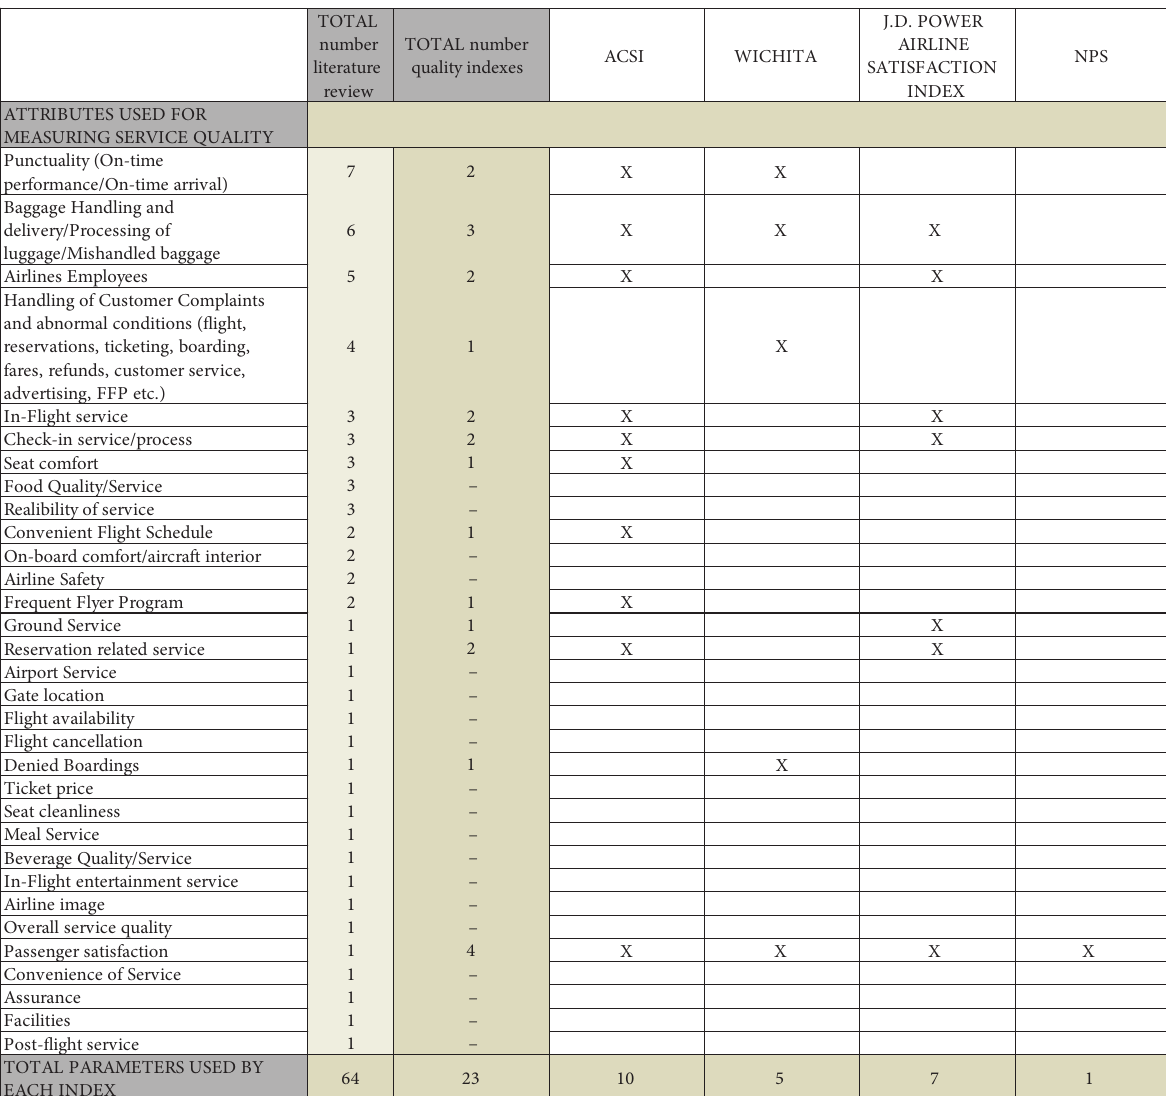
Table 1. Parameters mentioned by the literature and used by the four selected quality